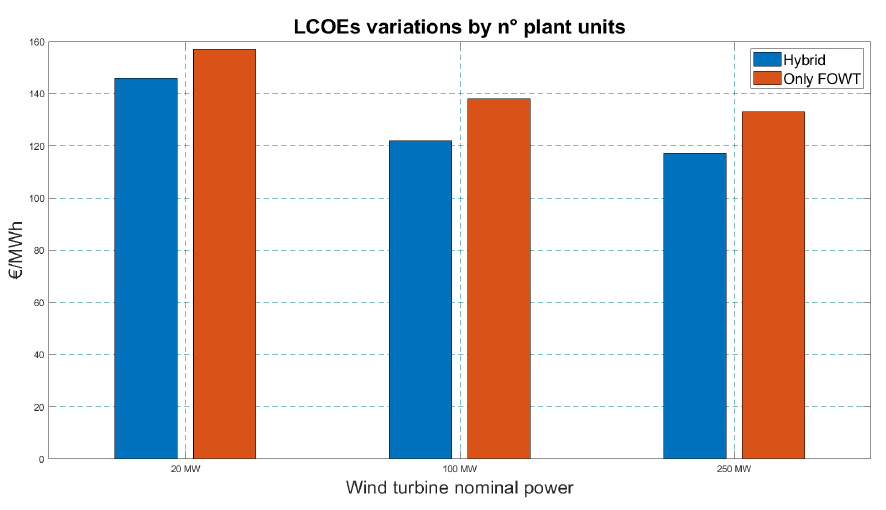
Figure 24. LCOE variation by wind turbines